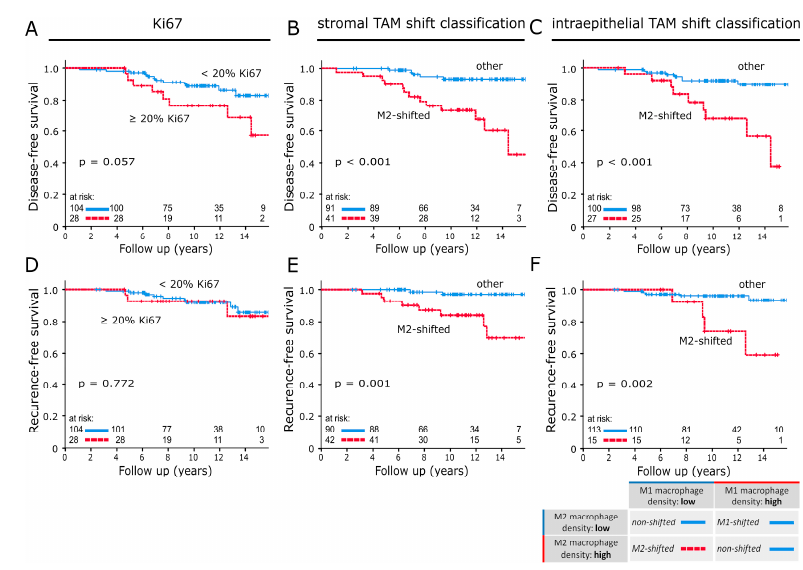
Figure 4. Disease-free survival analysed with the Kaplan–Meier method and log-rank test according to ( A ) Ki67 and ( B , C ) the TAM shift classification applied to invasive front samples. In-breast recurrence-free survival analysed with the Kaplan–Meier method and log-rank test according to ( D ) Ki67 and ( E , F ) the TAM shift classification applied to invasive front samples. In ( B , C , E , F ), M2-shifted was compared to the remaining two groups of the TAM shift classification. The table below the survival plots gives a detailed explanation of group